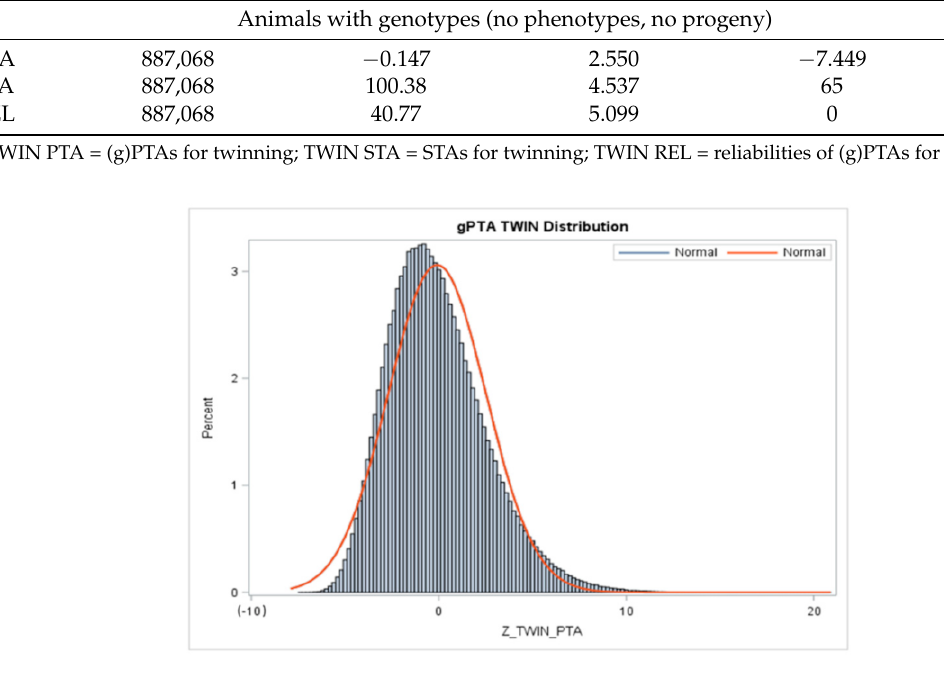
Figure 1. Distribution of (g)PTAs (Z_TWIN_PTA) for twinning for all animals in the Holstein evaluation. An appreciable variation in (g)PTAs is observed in the Holstein population sampled in the present study.